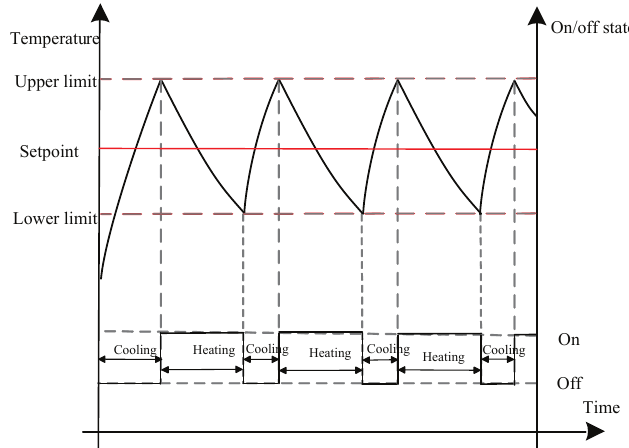
Figure 2. Operational characteristics of a thermostatically controlled load (TCL) when the temperature setpoint is constant.